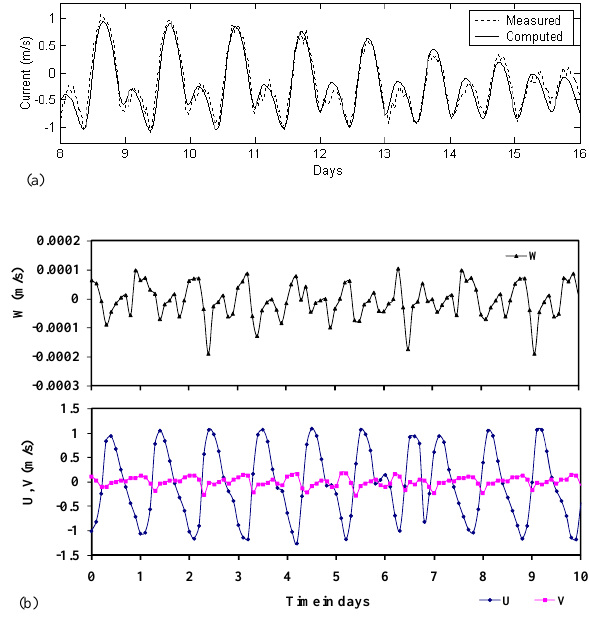
Fig. 2. (a) Comparison of TMH model computed and measured currents at the control point “ESS” in the east of the Singapore Strait (Chan et al., 2006); (b) Current velocity components U, V and W from TMH model at “SS” station during typical SWM in the west of the Singapore Strait.